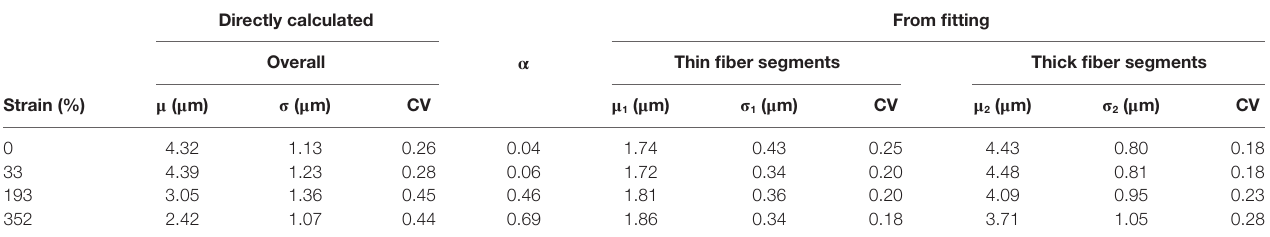
Directly calculated From fitting Thin fiber segments